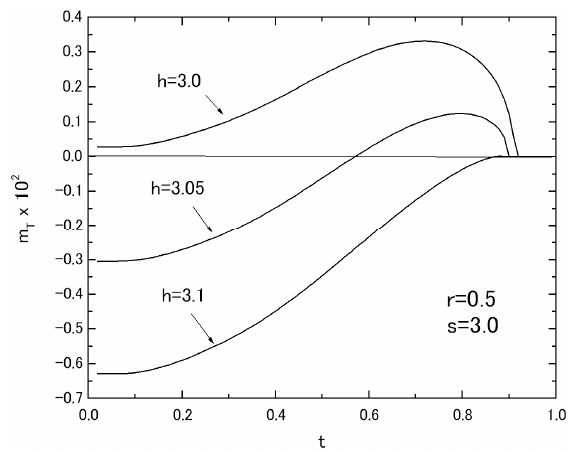
Figure 9. The temperature dependences of m T in the system B with r = 0.5 and s = 3.0, when the three values of h are selected.